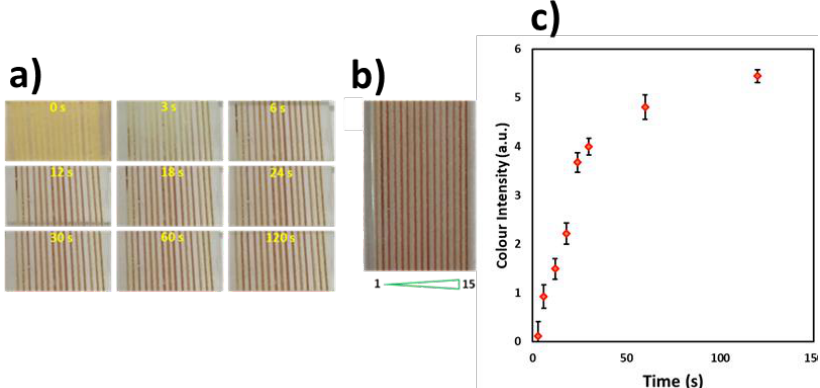
Figure 4. Nitrocefin-coated microchip dipped in a β -lactamase solution. ( a ) Time-lapse photos of the reaction at different times (3, 6, 12, 18, 24, 30, 60 and 120 s), ( b ) Still photograph after completion of the reaction at 2 min. ( c ) Graph showing the colour intensity change at different times. The colour intensity variability in the 15 channels was found to be 5% (%RSD).